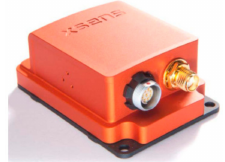
Figure 2. The MTi-300 AHRS sensor.